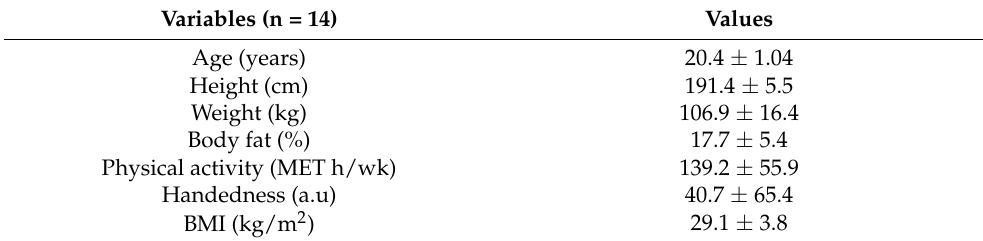
Table 1. Subject Characteristics.